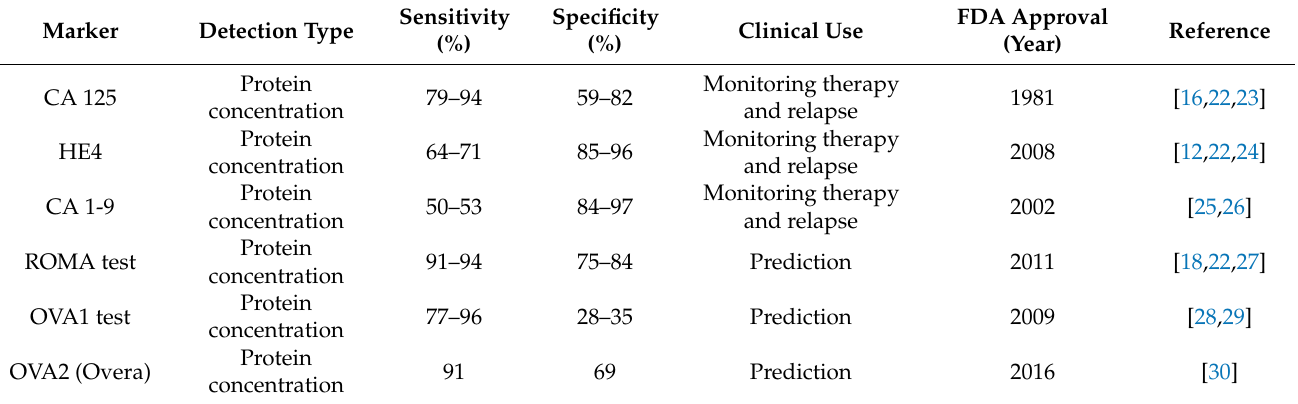
Table 1. Clinically approved glycosylated ovarian cancer